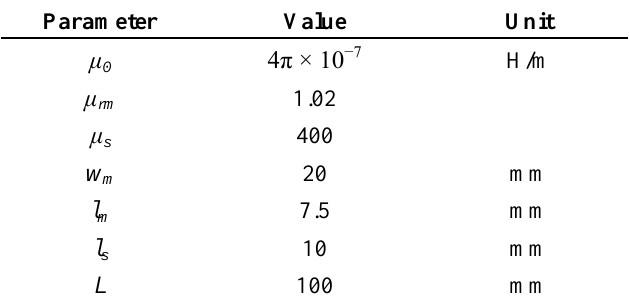
Table 1. Parameters of the LM.